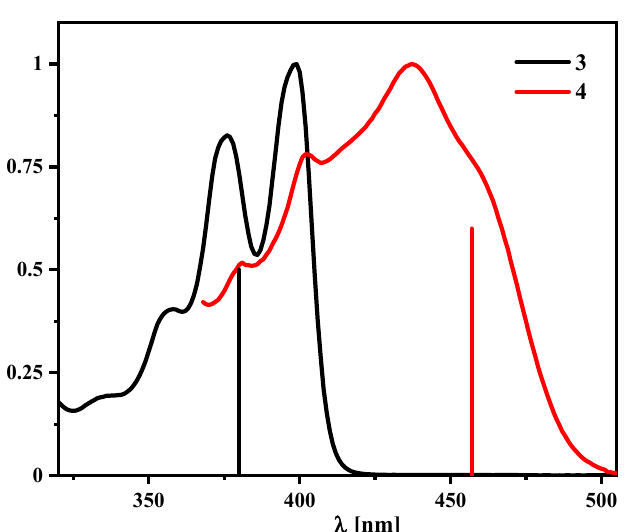
Figure 11. Comparison of calculated (vertical lines) and experimental electronic absorption spectra of 3 and 4 .